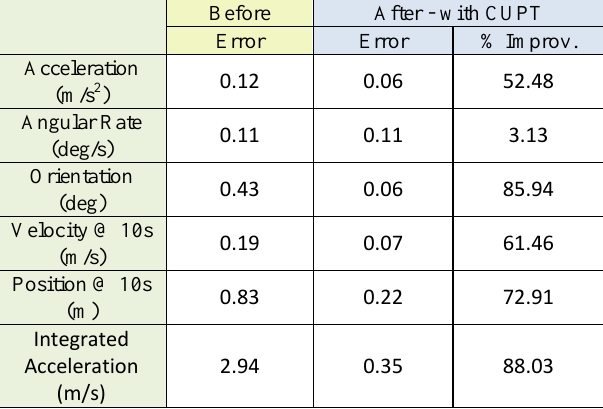
Figure 8: (Top) the reference orientation of the checking smartphone/tablet trial determined by iMAR; (Middle) orientation errors from integrating the gyroscope signal; (Bottom) accelerometer errors from integrating the accelerometer signal in a rotating frame before and after in-situ self-calibration with CUPT. Before After - with CUPT % Improv.